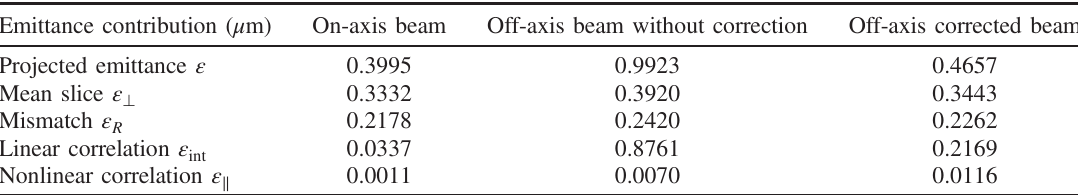
TABLE VI. Decomposition of the final vertical projected emittance for the off-axis beam, both with and without correction. The corresponding result for the on-axis beam is shown for comparison. Space charge is included in each simulation.